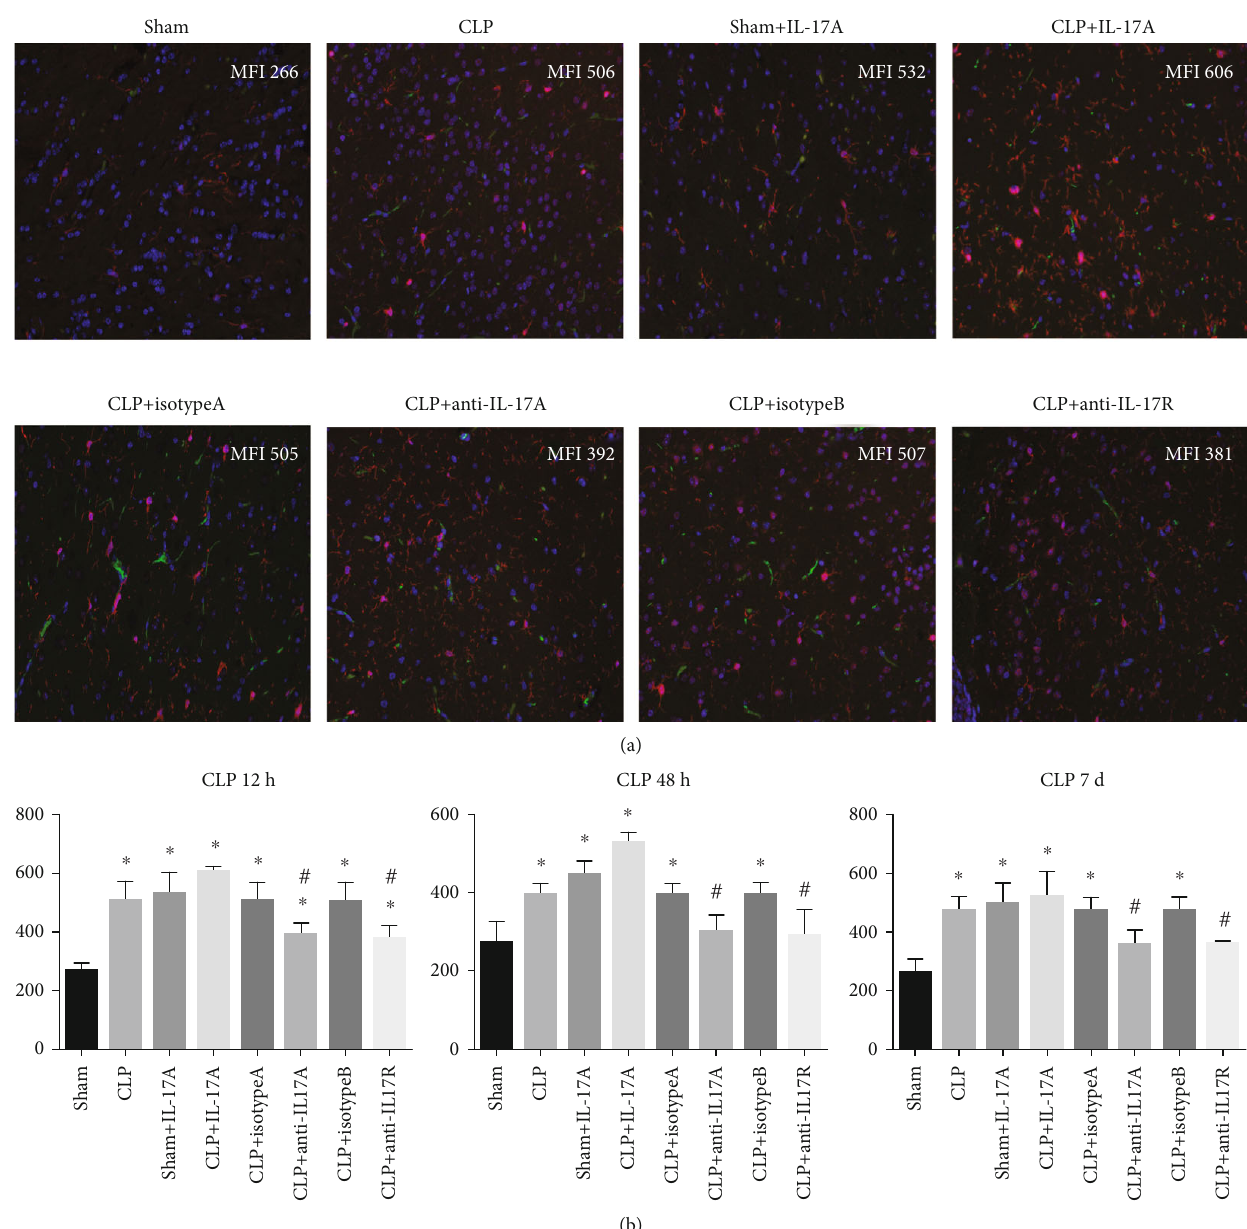
Figure 5: Microglia activation was determined by IF after modulation of the IL-17A/IL-17R pathway. (a) Representative image of the IF assay in the hippocampus at 12 hours post surgery (1 : 200). Specimens were stained with CD11b (green), Iba-1 (red), and DAPI (blue). Mean fl uorescence intensity (MFI) of Iba-1 was shown in each image. (b) Summary data of the IF assay at 12 hours, 48 hours, and day 7 post CLP. ∗ P < 0 : 05 vs. sham control; # P < 0 : 05 (CLP+anti-IL17A ab vs. CLP+isotypeA; CLP+anti-IL17R ab vs.